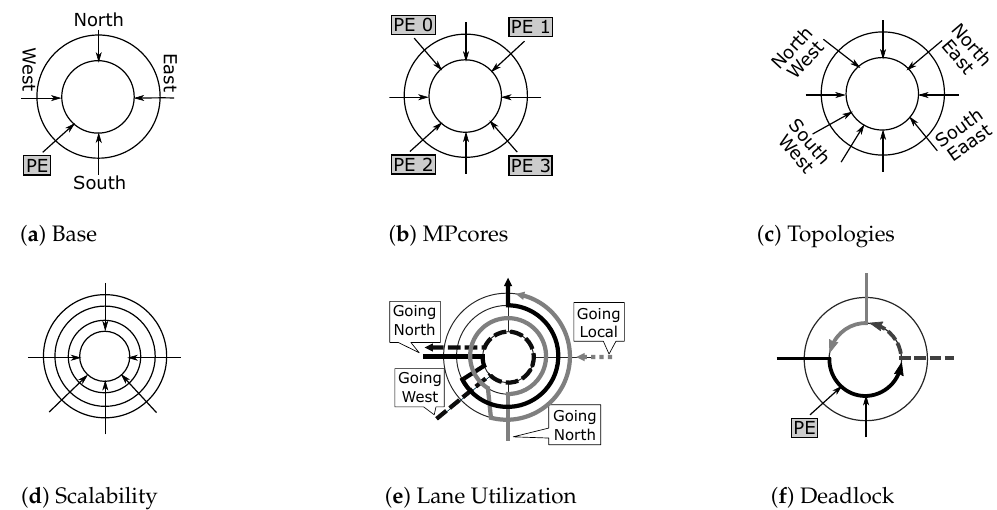
Figure 3. Initial deadlock-prone R-NoC topology and data-flows scenarios ( a – f